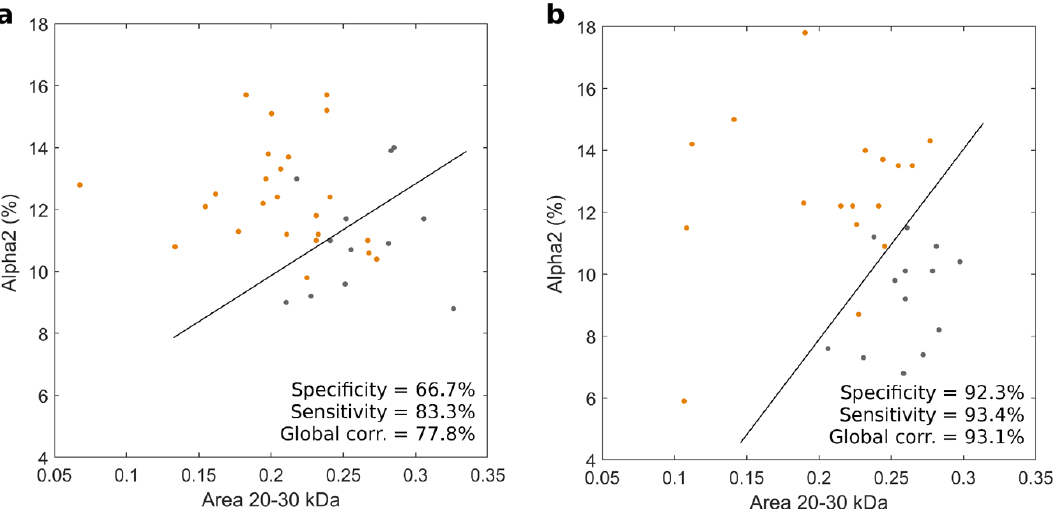
Figure 5. Sex-disaggregated scatter plots of the parameters show the largest difference between the 1D SDS-PAGE profiles for women (panel a ) and men (panel b ). Each point indicates a single human subject (orange for PDAC and black for healthy participants in the study). In both panels, the solid black lines describe the result of the linear discriminant analysis for the distributions.